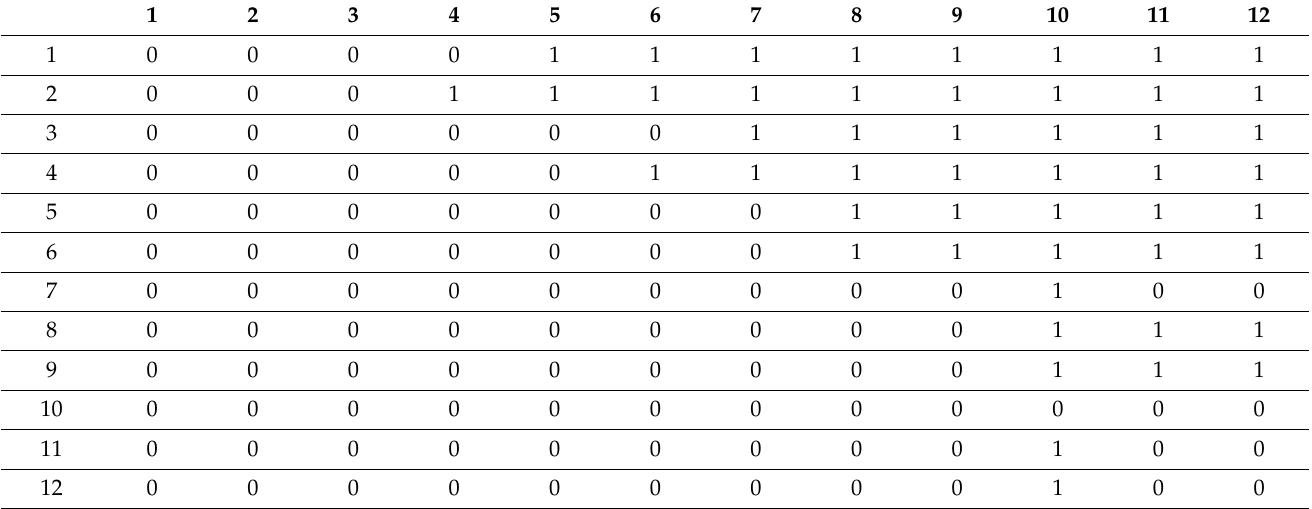
Table 6. Comparison relation